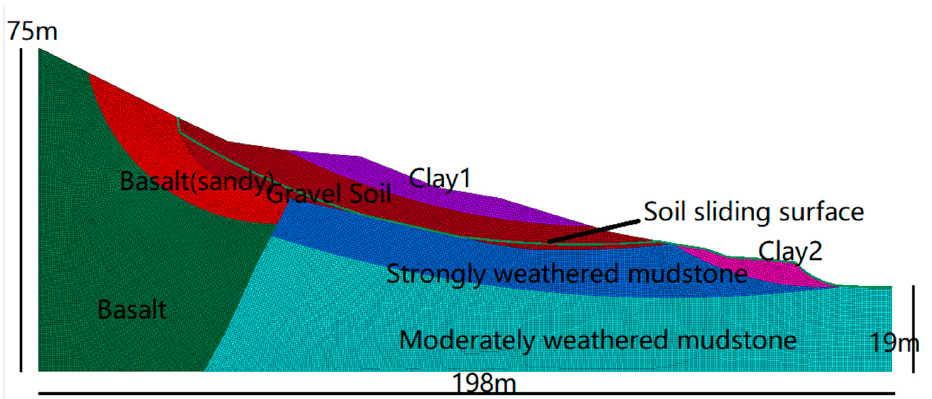
Figure 20. The numerical model of the profile.